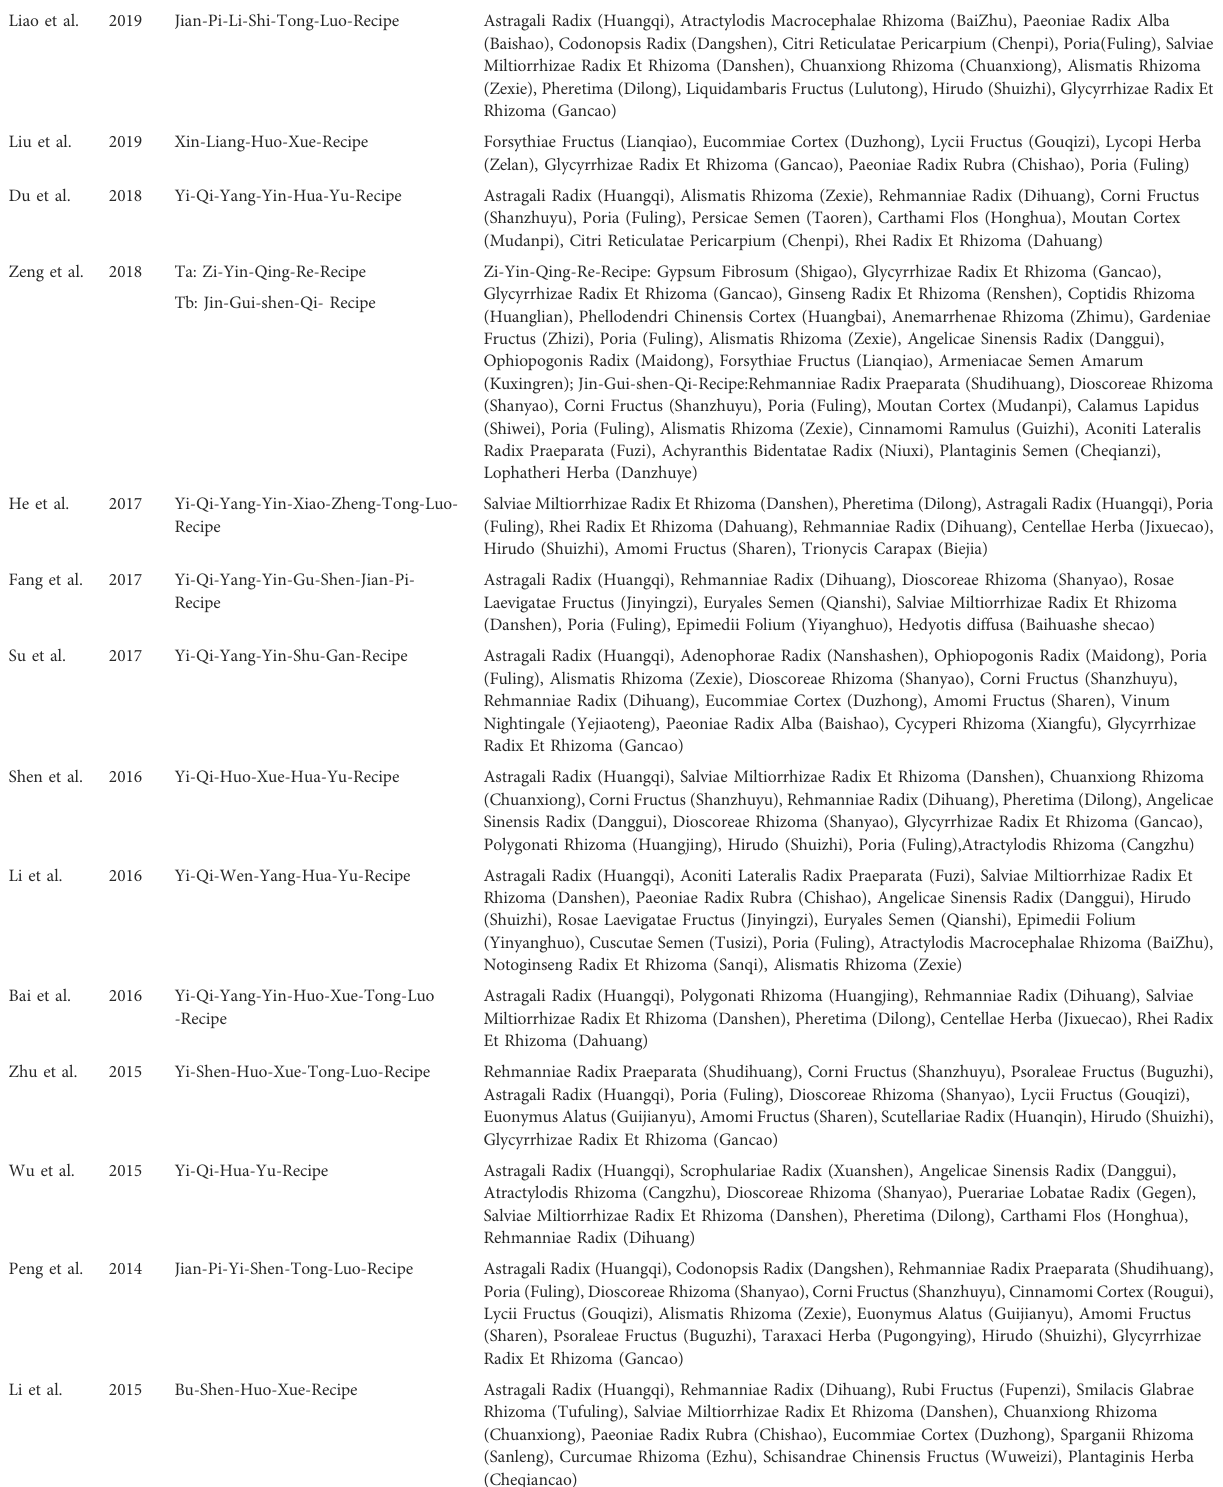
TABLE 3 Composition of traditional Chinese medicine reported in the included